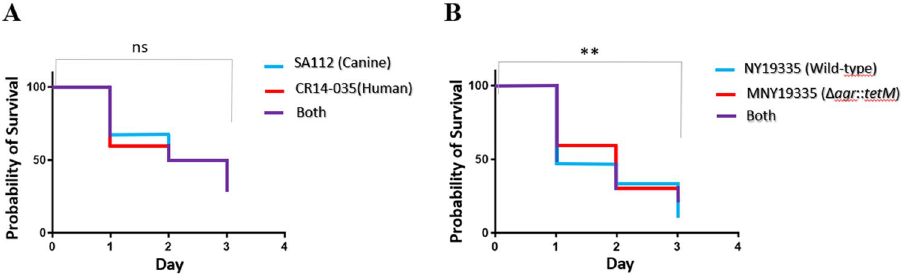
Figure 5. Comparison of survival curves of C. elegans to assess the virulence of the isolates. ( A ) The nematodes were separately infected with strain SA112, obtained from a dog and CR14-035, obtained from humans . ( B ) No significant difference was found. The set of strainsNY19335—an Agr-functional CC5 clinical isolate—and MNY19335∆ agr :: tetM —the isogenic agr knockout mutant—was used to control the experiments. Ns not significant; ** p <